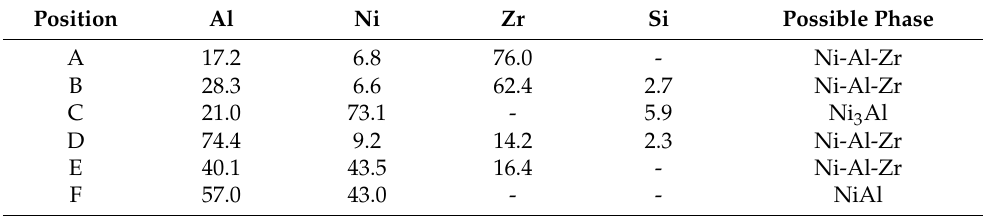
Table 2. EDS analysis results of each position in Figure 9